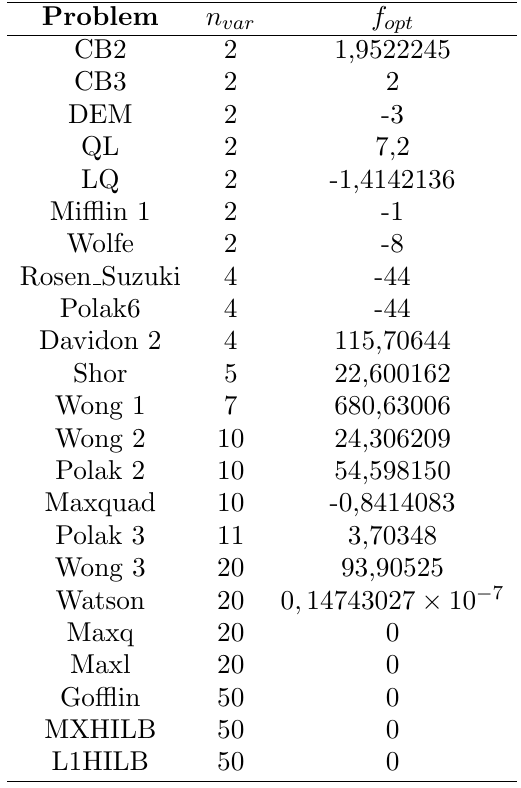
Table 1. List of Convex Problems